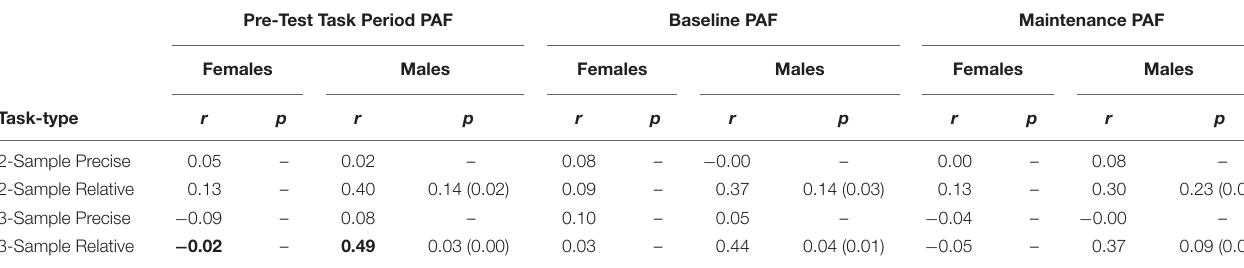
TABLE 3 | Correlations between accuracy and peak alpha frequency (PAF) during the pre-test task period, baseline and maintenance time periods (as shown in Figure 1 ). Pre-Test Task Period PAF Baseline PAF Maintenance